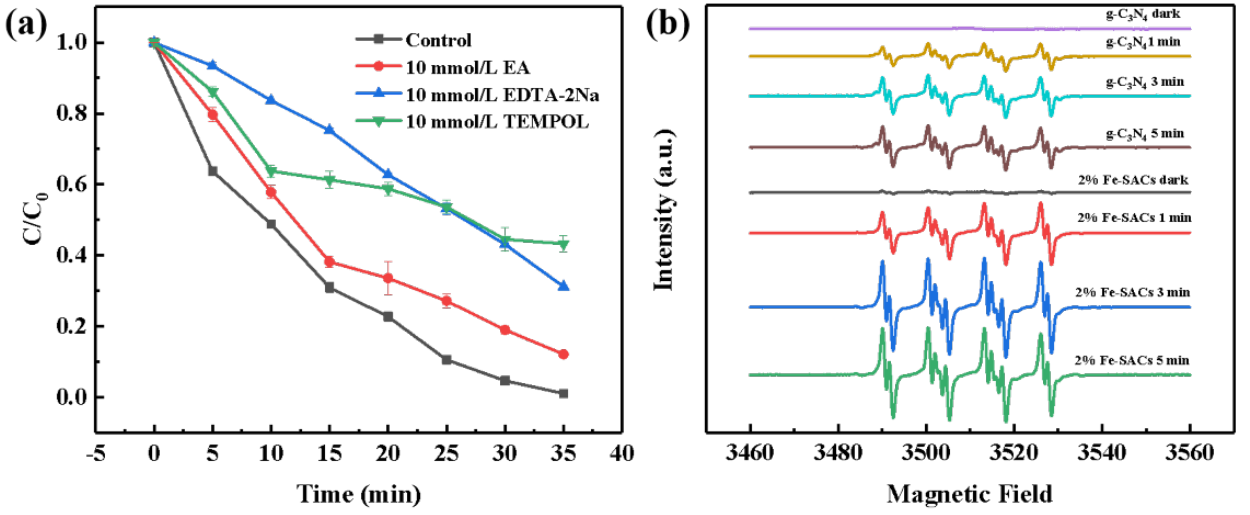
Figure 9. ( a ) The photocatalytic activity of Fe-SACs/g-C 3 N 4 for degrading MBT with the presence of various scavengers; ( b ) the EPR spectrum of DMPO-·O 2 − in the presence of g-C 3 N 4 and Fe-SACs/g- C 3 N 4 .